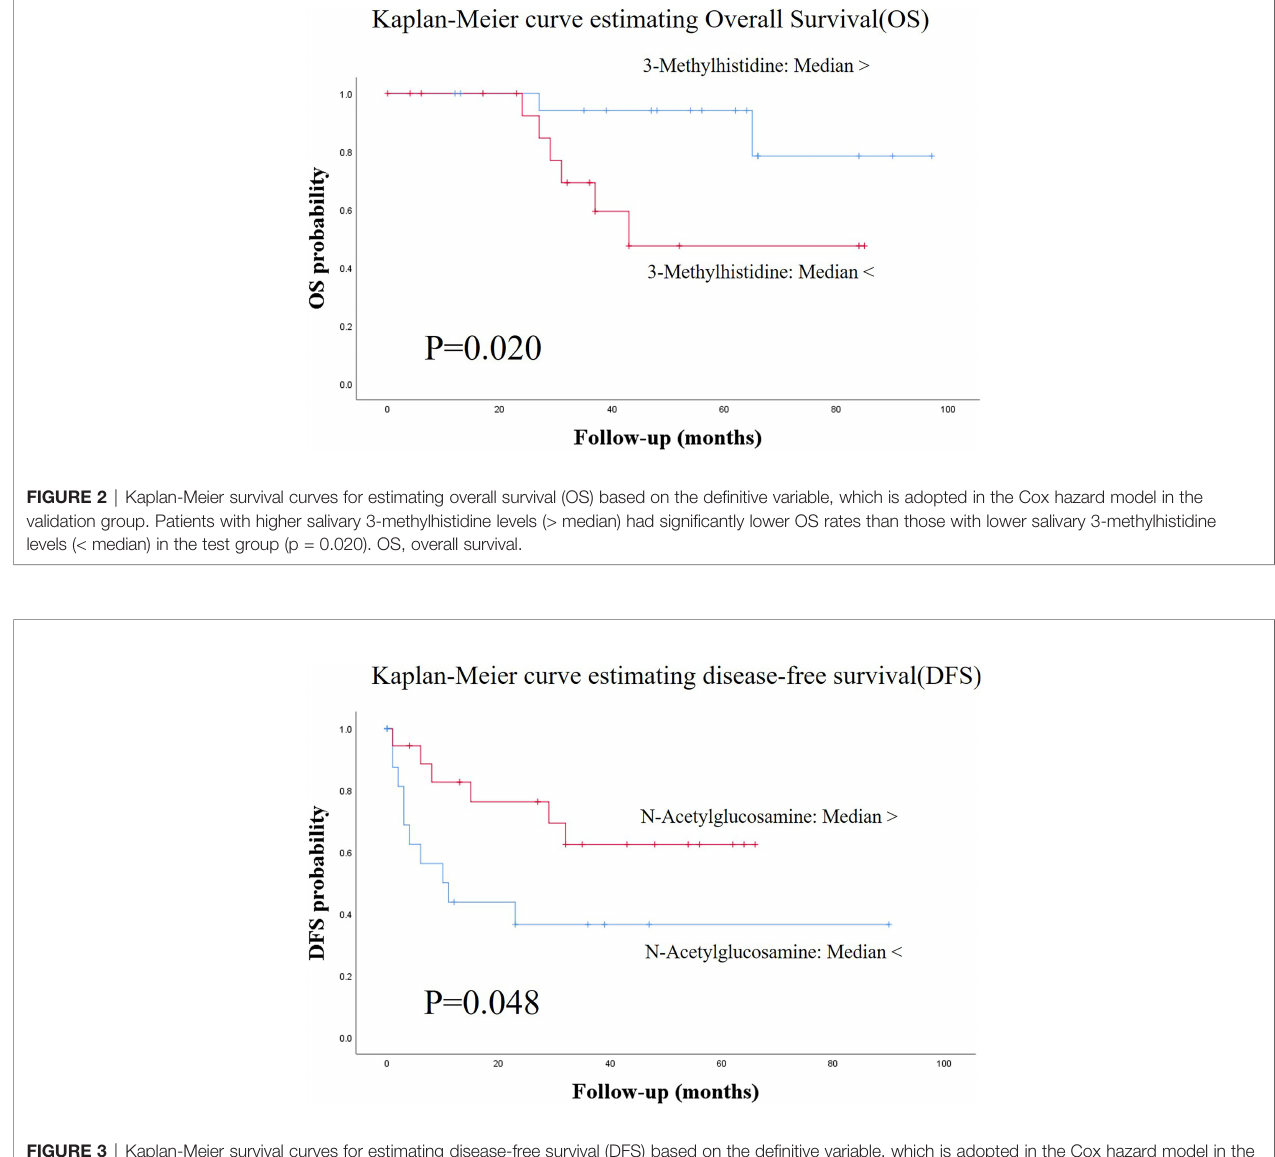
FIGURE 3 | Kaplan-Meier survival curves for estimating disease-free survival (DFS) based on the de fi nitive variable, which is adopted in the Cox hazard model in the validation group. Patients with lower salivary N-acetylglucosamine levels (< median) had signi fi cantly lower DFS than those with higher salivary N-acetylglucosamine levels (> median) in the validation group (p = 0.048). DFS, disease-free